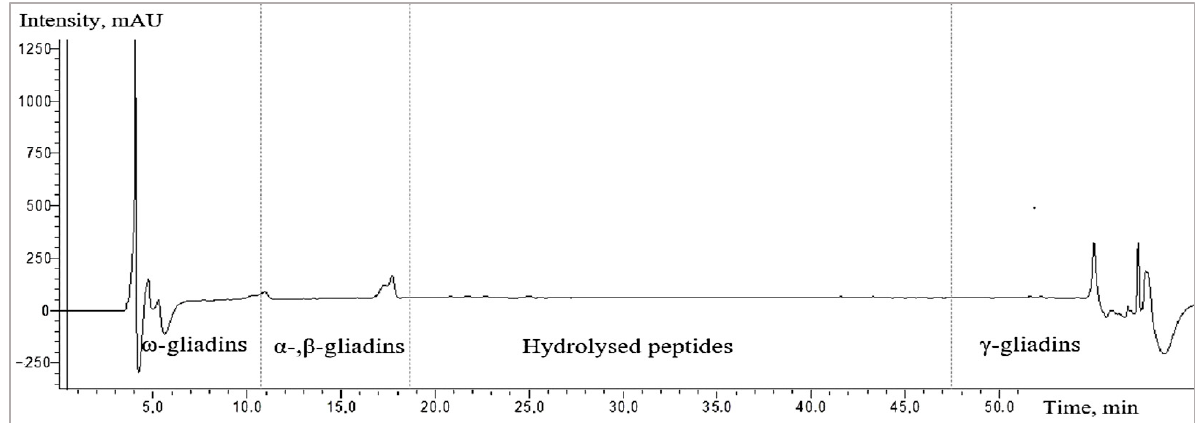
Figure 6. HPLC chromatogram of gliadin fraction of wheat bran samples treated with bromelain 4 h at 45 °C.